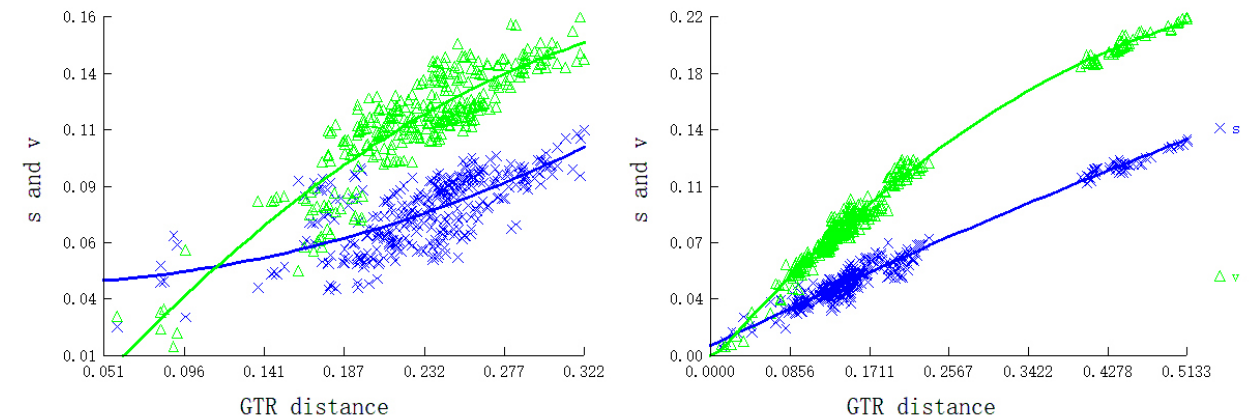
Figure 7. Substitution saturation plots of mt genomic PCGs and RNAs for 26 species. Plots in blue and green indicate transition and transversion, respectively.